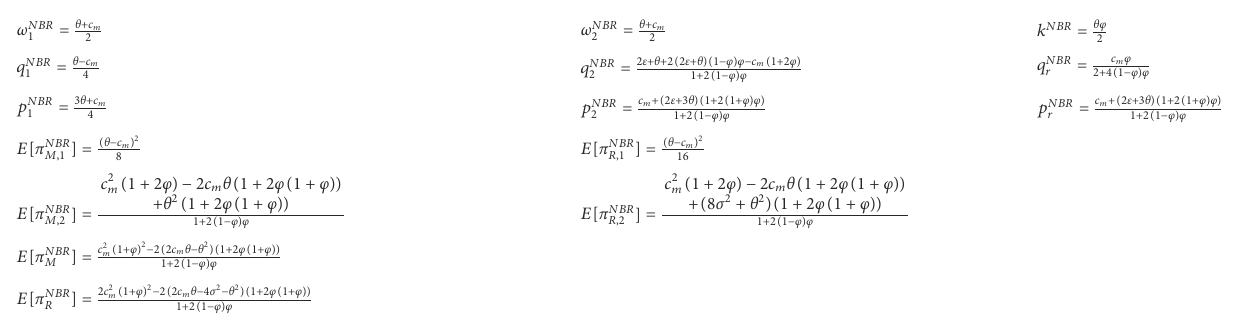
TABLE 3 The equilibrium outcomes of NBR scenario.